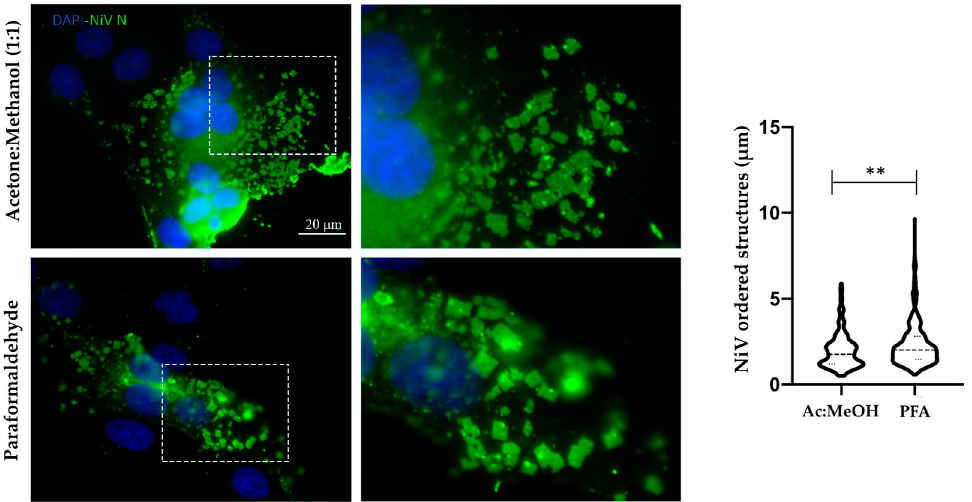
Figure 2. Sample fixation method does not affect NiV rhombohedron structure formation. On the left, microphotographs of NiV infected Vero E6 cells fixed with acetone:methanol (Ac:MeOH) or 4.5% paraformaldehyde (PFA). NiV nucleoprotein (N) is labeled in green and nuclei in blue; scale bar: 20 µm. Panels in the middle column represent enlarged versions of the inset box. On the right, a representative quantification of ordered structure size in samples fixed with either Ac:MeOH or 4.5% PFA is depicted. A total of 9 images from 3 independent experiments per method were used. A non-parametric Mann–Whitney test showed significant differences between the fixation methods. Significance is indicated by ** for p < 0.01.